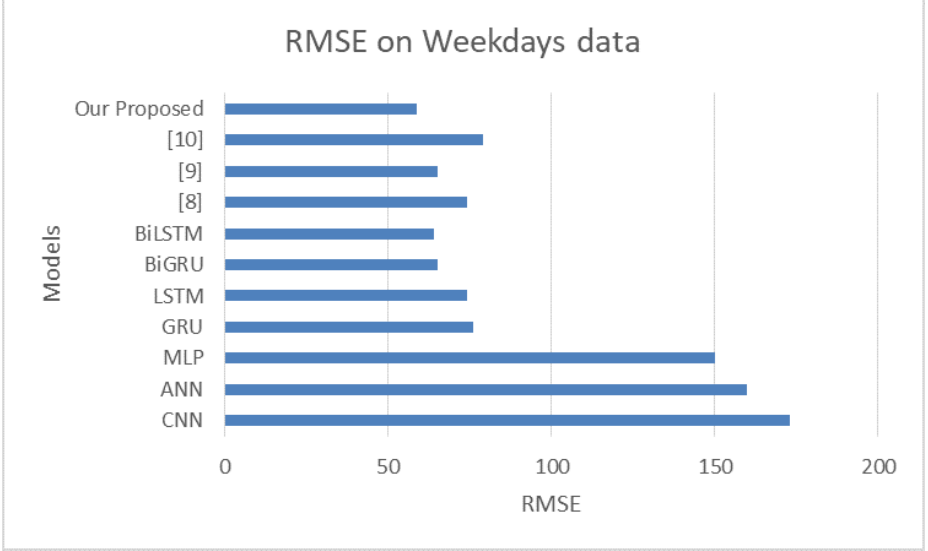
Figure 11. A comparison of the RMSE values with and without the weekend data.